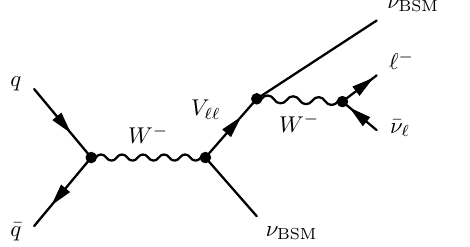
Figure 4. Leading-order Feynman diagrams for the VLBSM topologies. The same nomenclature as seen in figure 2 applies